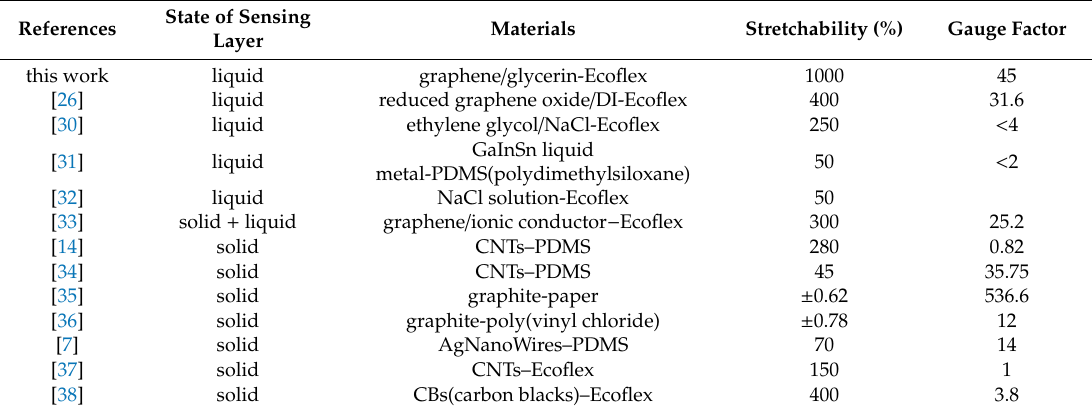
Table 1. Summary of performance results of recently reported stretchable strain sensors based on graphene or liquid conductors.